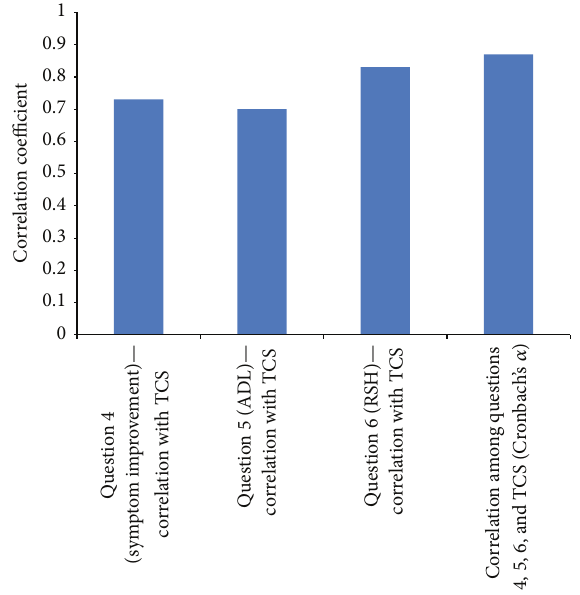
Figure 4: Correlations among total composite score and individual items (Total composite score calculated as the sum of scores from Questions 4, 5, and 6 from Part 2 of the ARMS questionnaire). ADL; activities of daily living; RSH: return to previous state of health; TCS: total composite